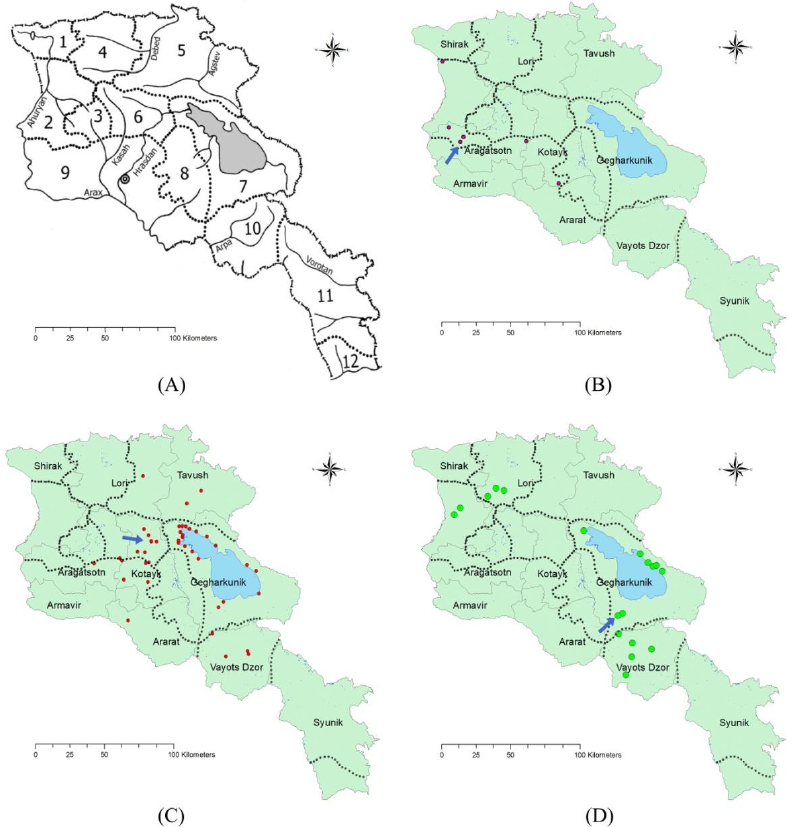
Figure 1. Maps of the floristic regions of Armenia ( A ): 1—Upper Akhuryan; 2—Shirak; 3—Aragats; 4—Lori; 5—Ijevan; 6—Aparan; 7—Sevan; 8—Gegham; 9—Yerevan; 10—Darelegis; 11—Zangezur; 12—Meghri; and geographical locations of the three Beta wild species in Armenia: B. lomatogona ( B ), B. corolliflora ( C ) and B. macrorhiza ( D ). The selected locations for annual observations described in this paper are shown with blue arrows. The distribution range of the species is shown in Figure S3 [32]. Table 1. Wild species of beet reported in Armenia. The table summarizes records of the wild beet species in Armenia, including information from the fieldworks of our group, accessible databases, catalogs, and published articles.